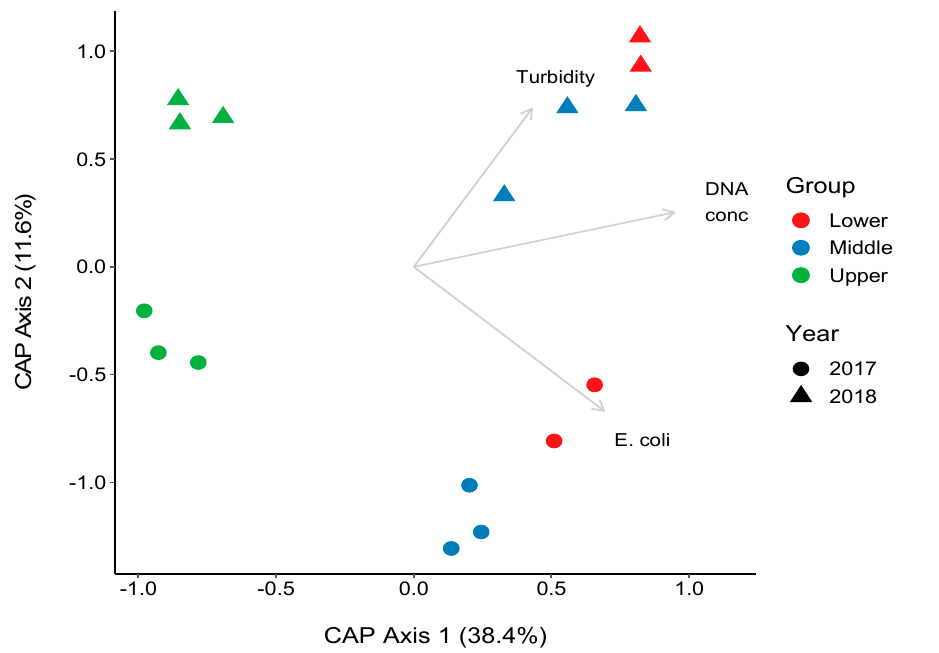
Figure 4. Canonical analysis of principal coordinates (CAP) plots showing the associations between environmental variables and the patterns in bacterial communities. Microbial communities were analyzed using Bray–Curtis distance matrices. All environmental variables shown in the plots had significant effects ( p < 0.05) on the microbial community patterns, based on PERMANOVA. Sites were divided into three groups based on the land-use patterns: the upper sites (S1–S3), the middle sites (S4–S6), and the lower sites (S7 and S8).